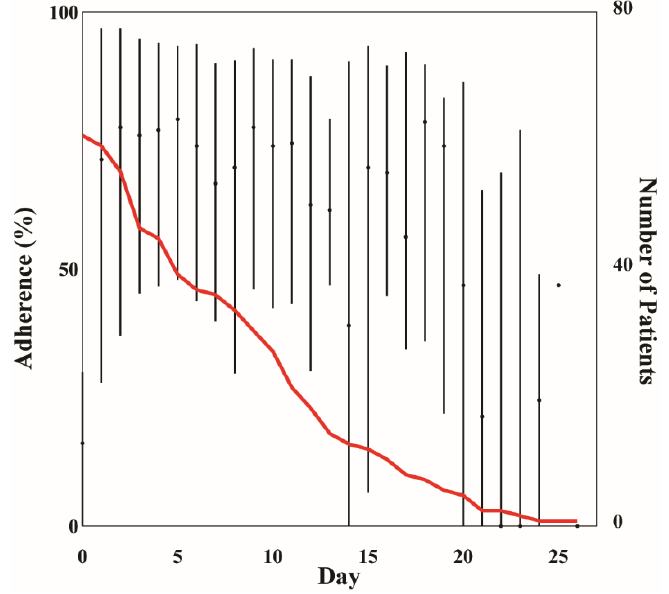
Figure 1. Median (IQR) adherence per day during healthcare at home (HaH) admission. The red line indicates the number of patients enrolled in HaH per day. Table 2. Alarm